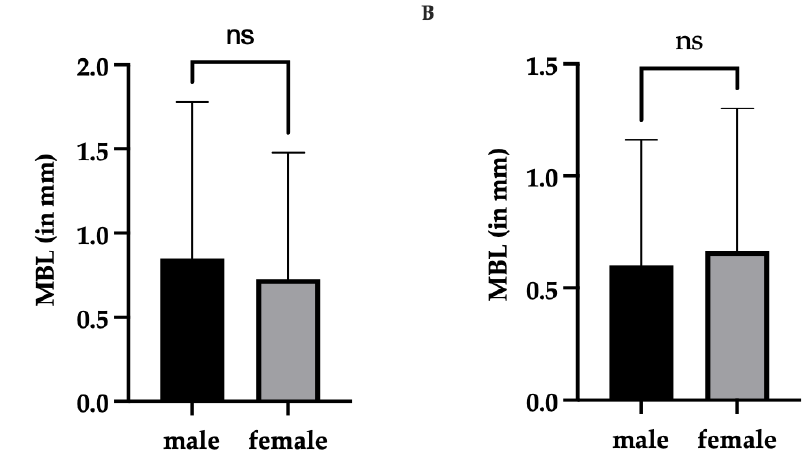
Table 2. Marginal bone loss (MBL) for both gender groups. Data are means ±SD.